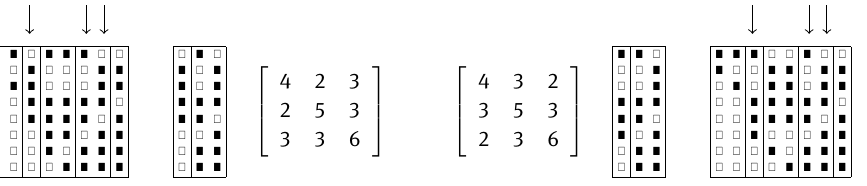
Figure 2: Examples of 0/1 -matrices representing acute 0/1 -simplices whose Gramians are not ultrametric. Columns 3,6,7 do not satisfy the inequalities in (68).